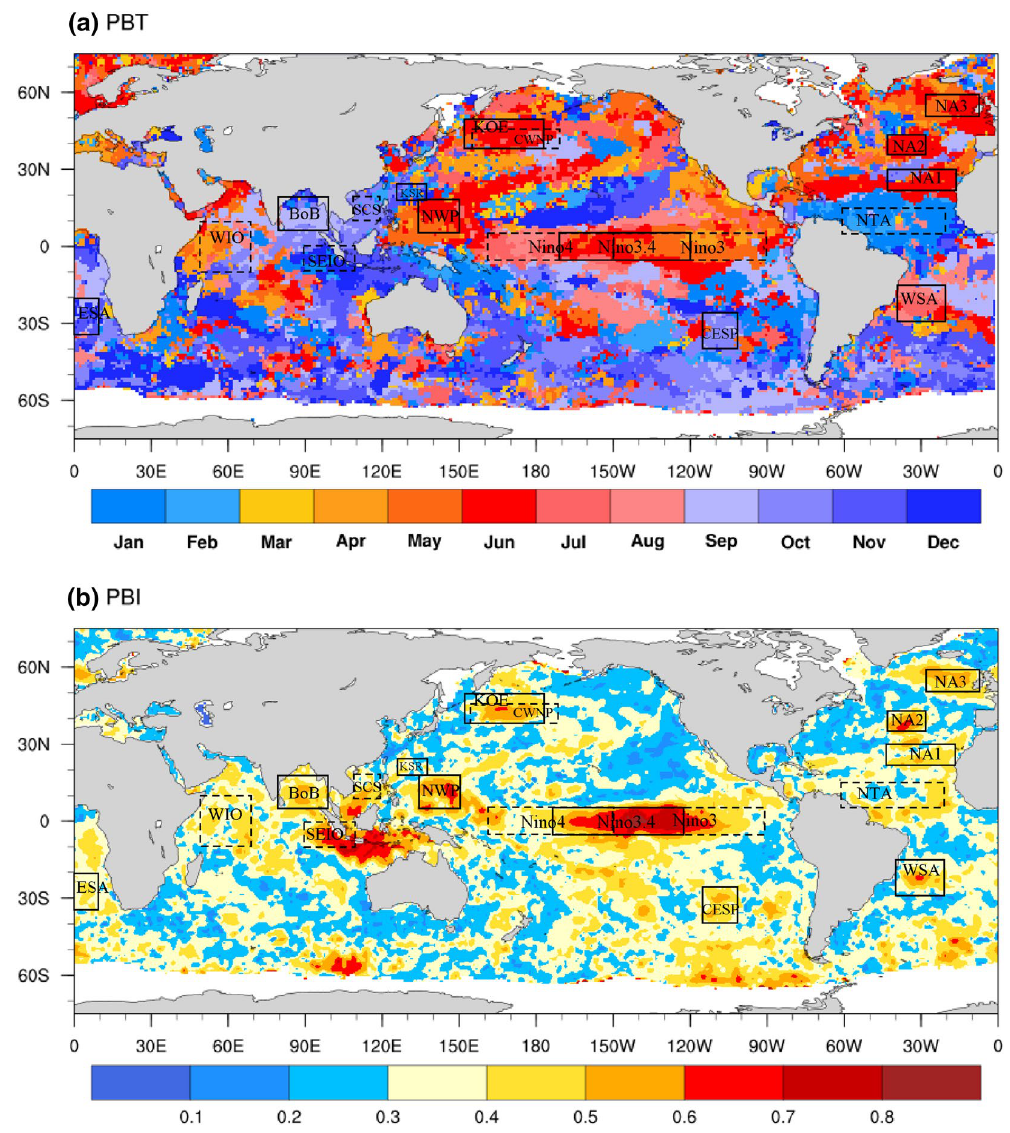
Fig. 2 a Global distribution of PBT. Shading is the PBT values. b Global distribution of PBI. Shading is the PBI values. The interference of sea ice has been removed. The dotted boxes are the area that others have studied. The solid boxes are the new specific area selected for this